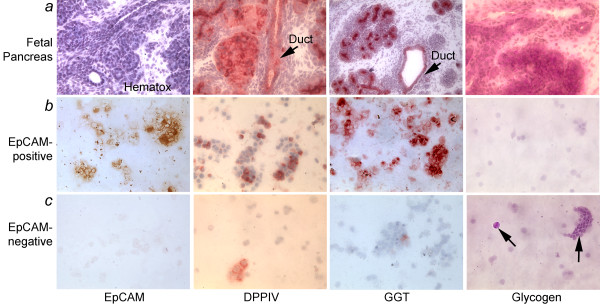
Fractionation of EpCAM-positive epithelial cells from fetal human pancreas. (a) shows intact 22-week fetal human pancreas with hematoxylin staining alone (extreme left) or histochemical staining for DPPIV, GGT and glycogen, as indicated, which were expressed in cells in ductal (arrows), periductal and acinar regions. (b) shows EpCAM-positive cells isolated by immunomagnetic cell sorting with EpCAM, DPPIV and GGT expression but absence of glycogen. (c) shows EpCAM-negative cell fraction with only occasional epithelial cells and more abundant glycogen-containing acinar cells (arrows, panel extreme right). Orig. mag., a, ×200; b and c, ×400.